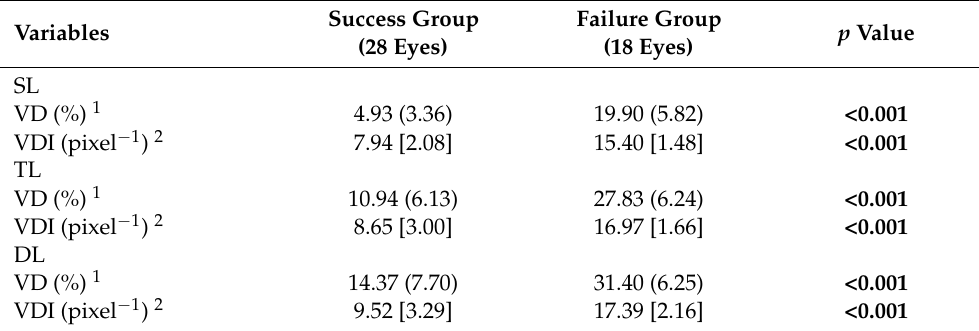
Table 2. Vasculature parameters in bleb area between success and failure group.